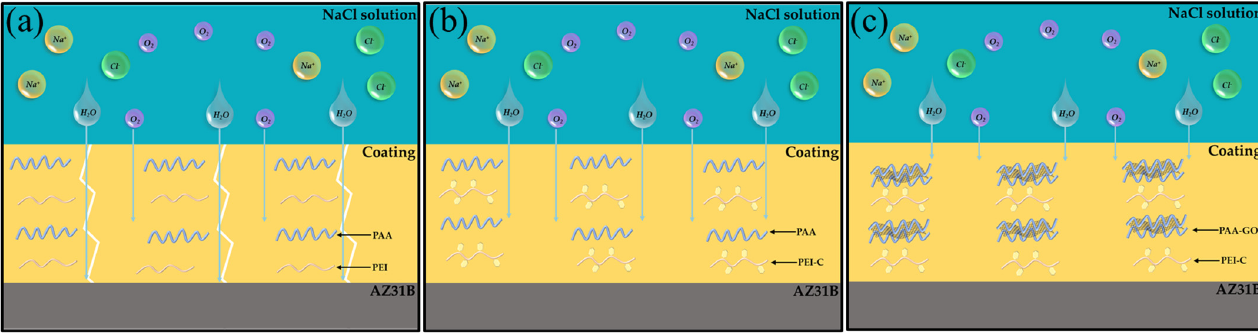
Figure 9. Corrosion mechanism diagrams of as-prepared coating systems for ( a ) Ce(IV)/PEI/PAA, ( b ) Ce(IV)/PEI-C/PAA, and ( c ) Ce(IV)/PEI-C/PAA-GO. ( b ) Ce(IV)/PEI-C/PAA, and ( c )